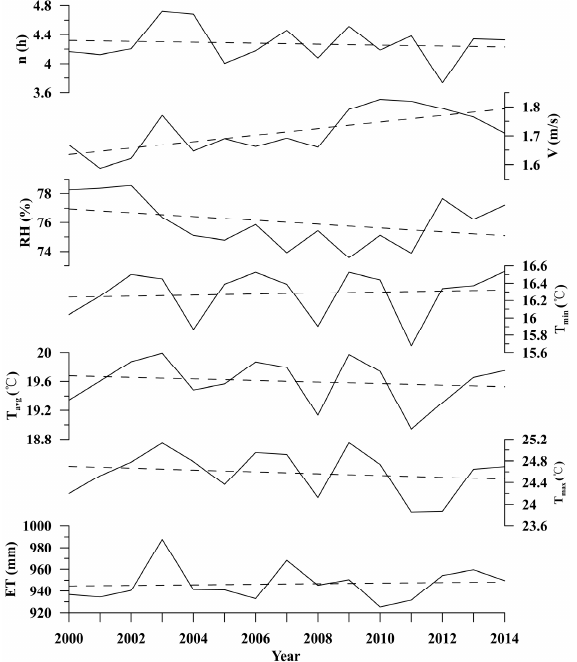
Figure 10. Dynamic changes in ET and its associated meteorological factors in the PRB.